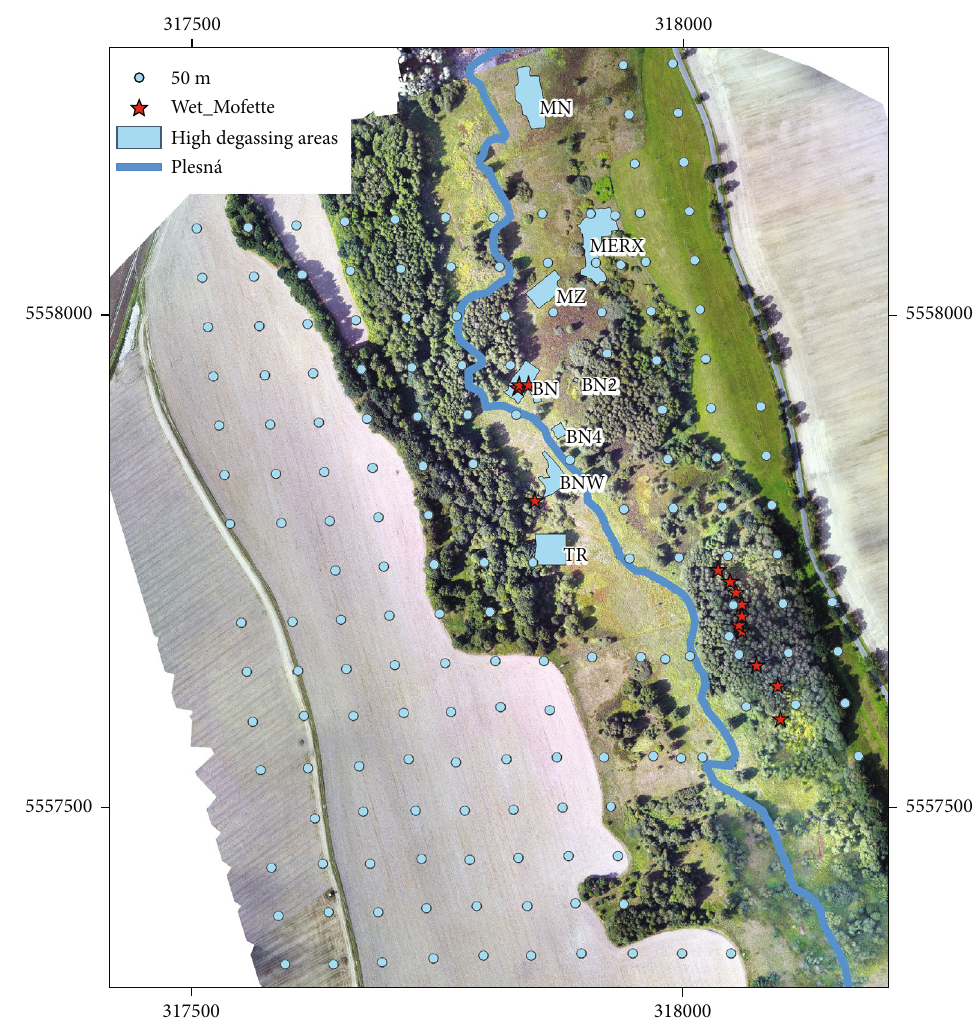
Figure 2: Overview of the Bublák and Milhostov areas. MERX: Milhostov East; MZ: Milhostov Central; MN: Milhostov North; BN: Bublák North; BN2: Bublák North 2; BN4: Bublák North 4; BNW: Bublák North-West; TR: